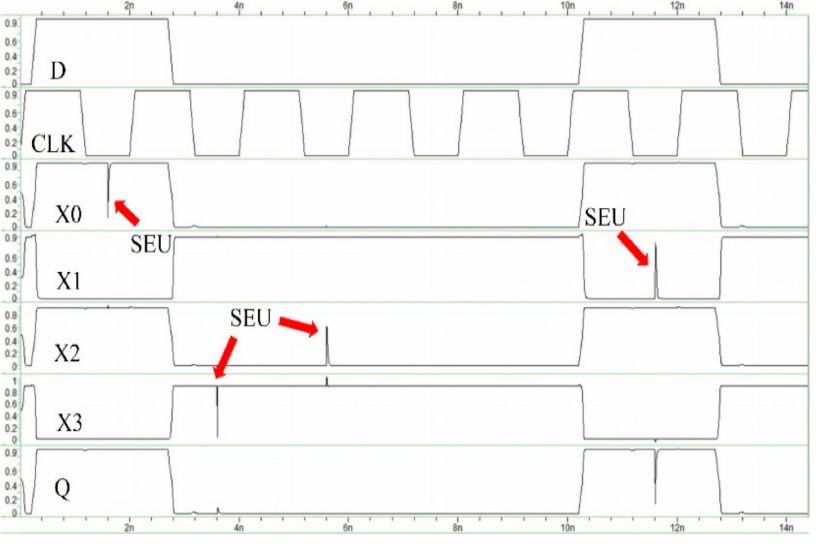
Figure 10. Simulation result during SEU